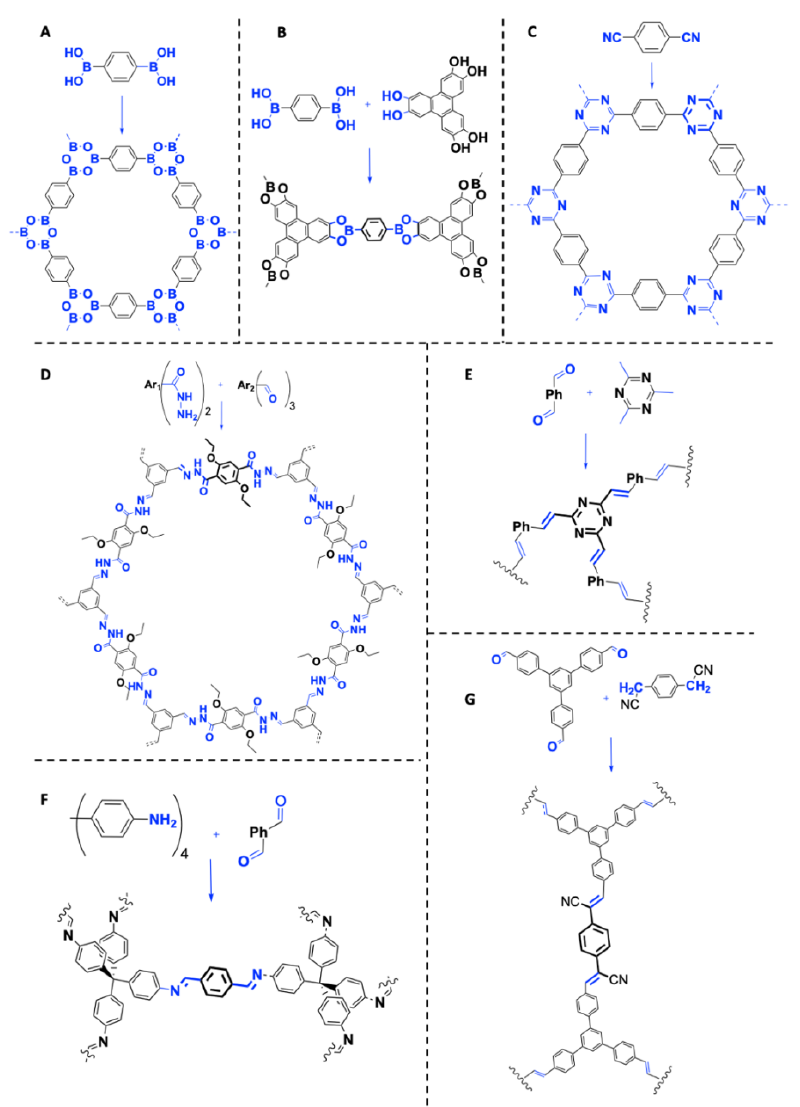
Figure 1. Examples of different reactive groups which allow DCC for COF formation and corresponding connecting moieties; ( A ) boroxine [24], ( B ) boronate ester [24], ( C ) triazine [25], ( D ) hydrazone [26], ( E ) vinylene with triazine [27,28], ( F ) imine [29], ( G ) full vinylene C-C bonded [30,31] (see the following references for full structures).